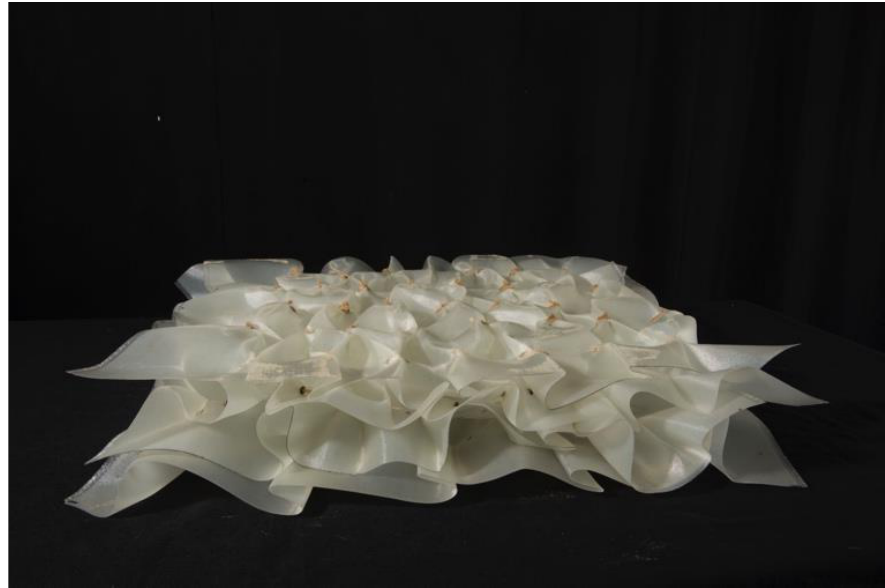
Figure 1. Layered FM-FRP material system (L-FMFRP) resulting in architectured material shaped as a thick panel.